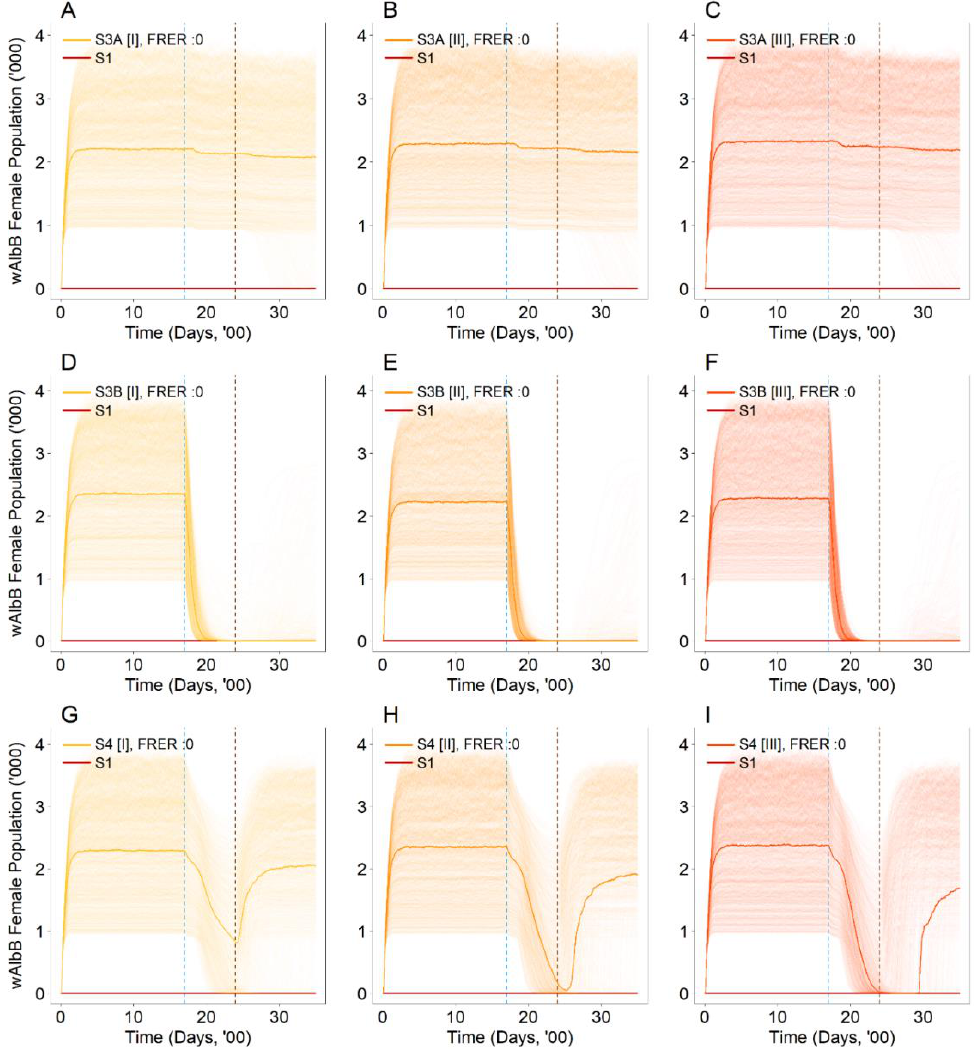
Figure 6. Number of Wolbachia ( w AlbB) female mosquitoes in the population with FRER: 0 with ( A ) Reduced intensity of 40,000 releases per week (S3A [I]), ( B ) Baseline intensity of 60,000 releases per week (S3A [II]) and ( C ) Increased intensity of 80,000 releases per week (S3A [II]) of male releases under the first strain female irradiation (S3A). Number of Wolbachia ( w AlbB) female mosquitoes in the population with FRER: 0 with ( D ) Reduced intensity of 40,000 releases per week (S3B [I]), ( E ) Baseline intensity of 60,000 releases per week (S3B [II]) and ( F ) Increased intensity of 80,000 releases per week (S3B [II]) of male releases under the first strain male and female irradiation (S3B). Number of Wolbachia ( w AlbB) female mosquitoes in the population with FRER: 0 with ( G ) Reduced intensity of 40,000 releases per week (S3B [I]), ( H ) Baseline intensity of 60,000 releases per week (S3B [II]) and ( I ) Increased intensity of 80,000 releases per week (S3B [II]) of male releases under the second strain introduction (S4). The lighter shade solid lines represent the 1000 simulations, and the dark solid lines represent the median of the 1000 simulations. The blue and brown dotted vertical line represents the start and end of the intervention (S3A, S3B and S4) respectively. The red solid line represents the baseline scenario (S1).